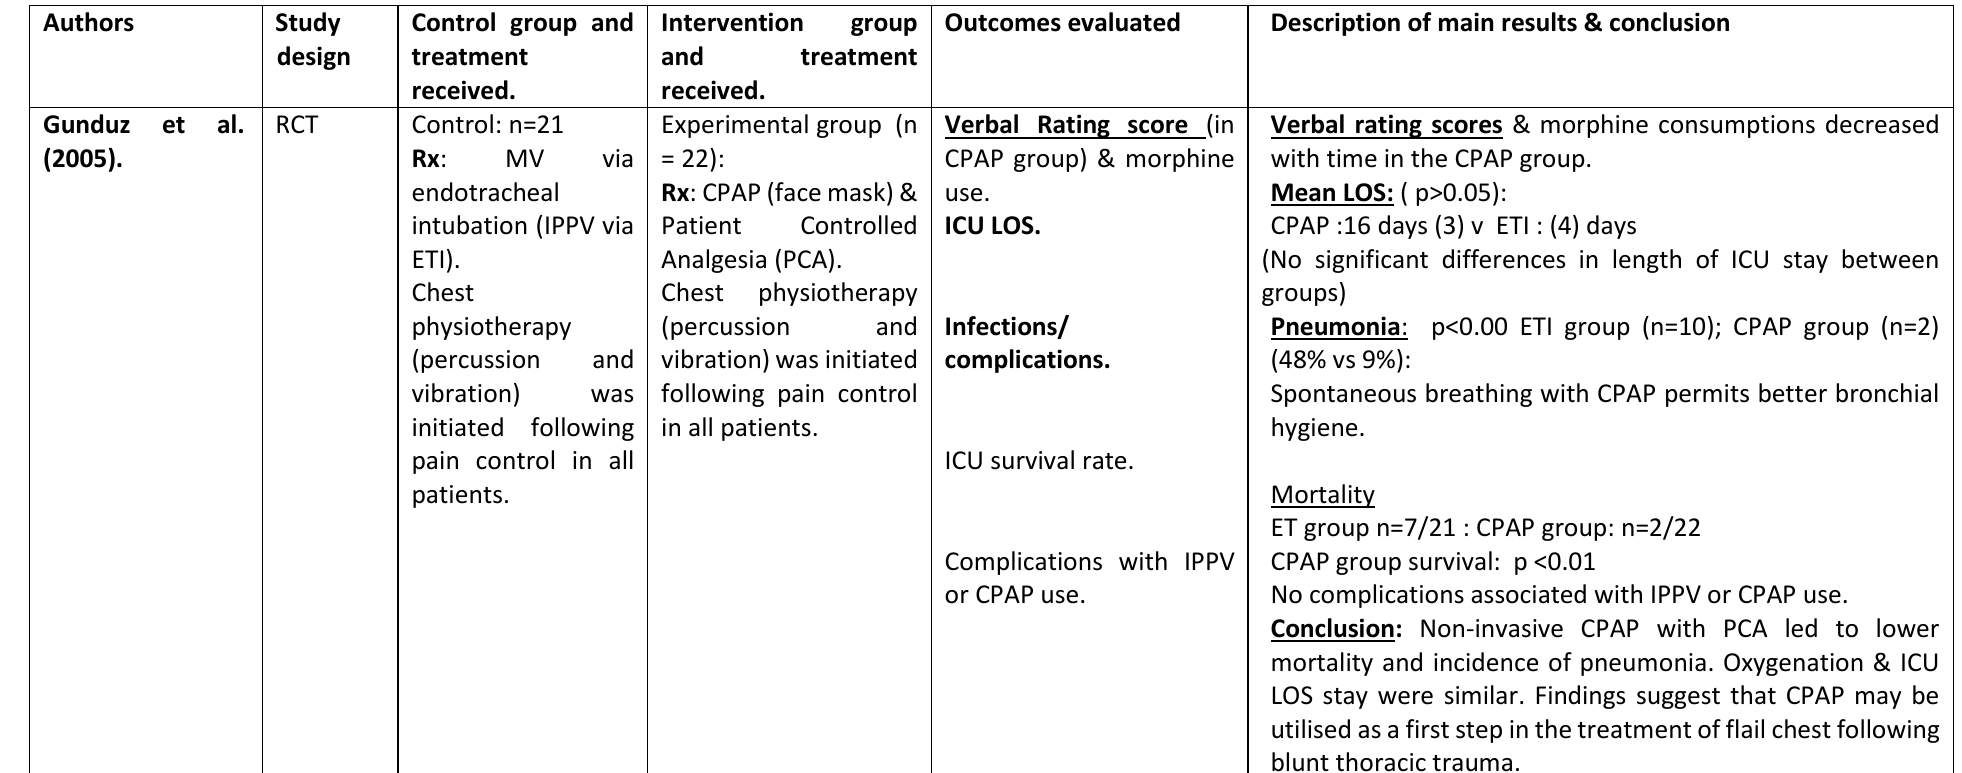
TABLE 12-A1: Interventions and outcomes of included